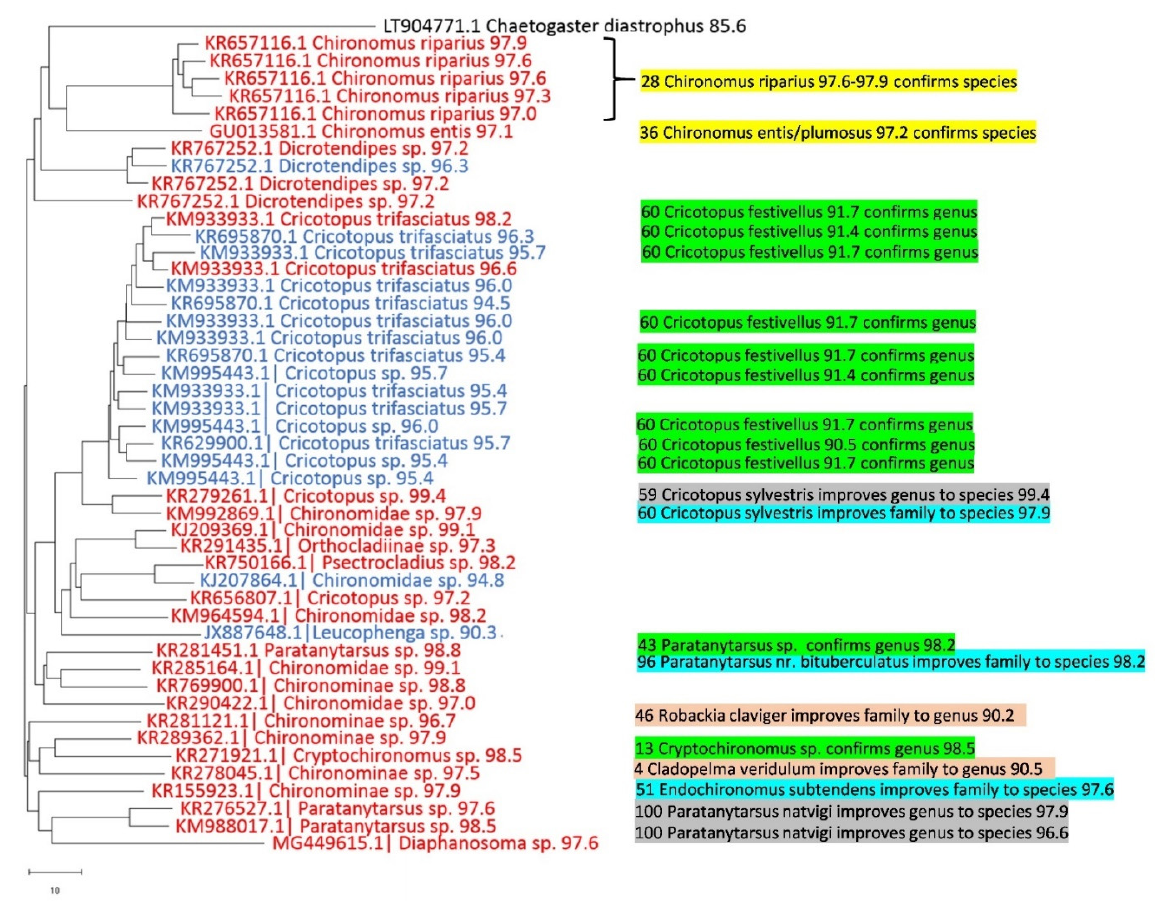
Figure 4. A representative example of confirmed and improved identification of water mite dietary content using the curated chironomid barcode database. The neighbor-joining tree (reproduced from Vasquez, Mohiddin, Li, Bonnici, Gurdziel and Ram [15] ) aligns with the confirmations of identification highlighted in yellow for species and green for genus. Additionally, improvements are highlighted: grey for genus to species, blue for family to species and brown for family to genus. The curated sequence names are listed in the following format: Lab ID branch number, genus or species, percent similarity to the mite diet sequence.